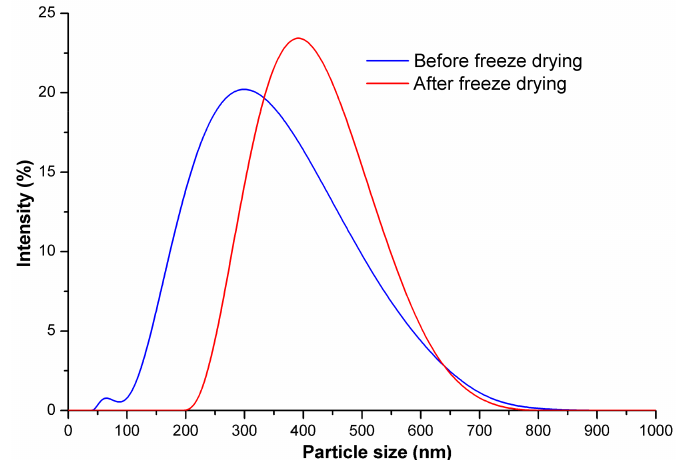
Figure 2. Cellulose nanocrystal (CNC) particle-size distributions before and after freeze drying. Dynamic light-scattering (DLS) measurements were performed in DI H 2 O for the never-dried and the freeze-dried CNC